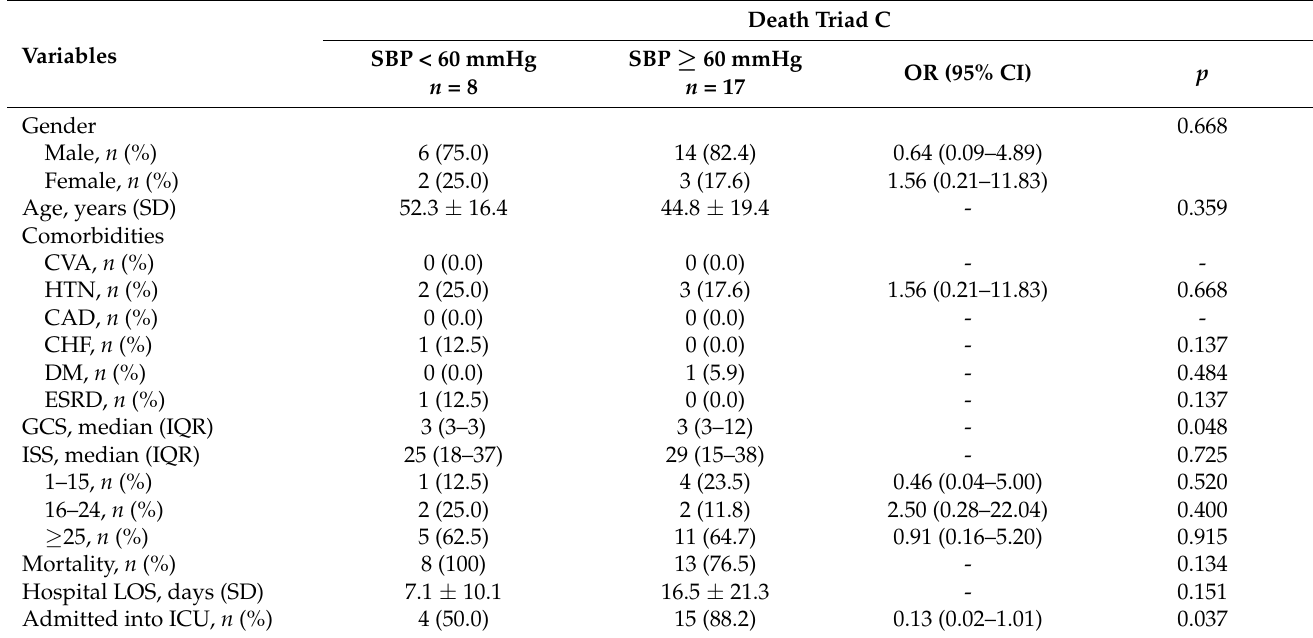
Table 4. The injury characteristics and outcome of trauma patients in death triad C with or without systolic blood pressure less than 60